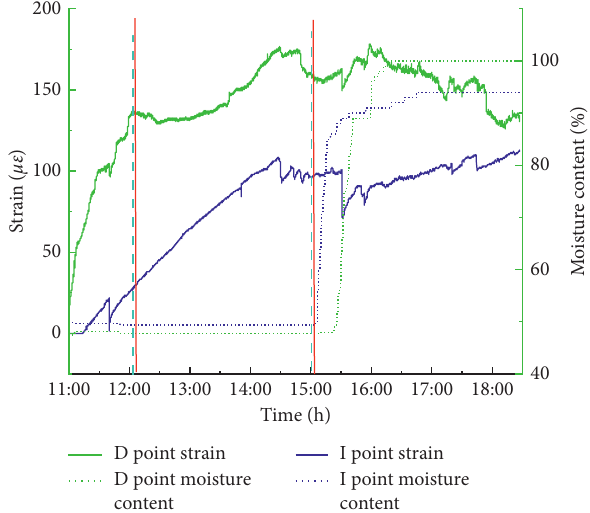
Figure 14: D, I measuring points strain-water content time history